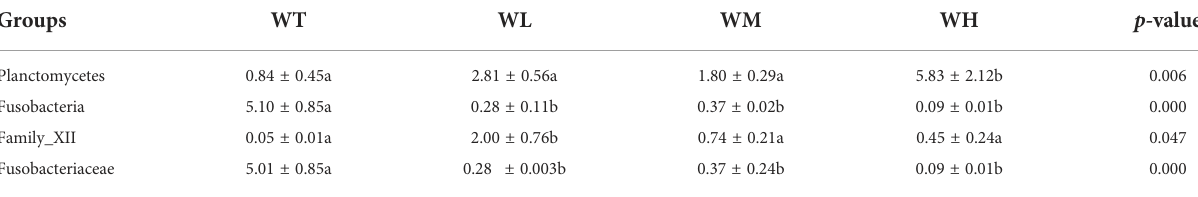
TABLE 4 Differences in the relative abundance of rearing water microbiota among four different